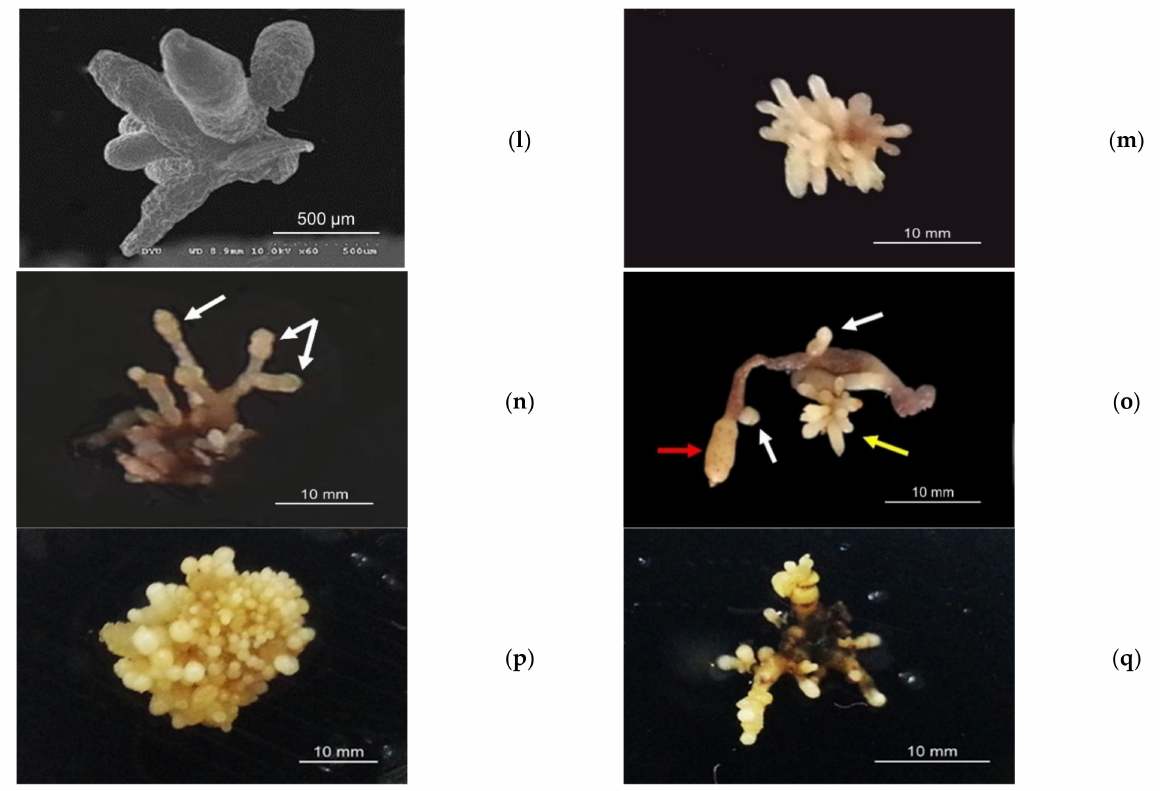
Figure 2. The in vitro asymbiotic germination of seeds of G. elata into protocorms and the develop- ment of juvenile rhizomes (jrhs). ( a ) The undifferentiated embryo in seeds started cell division and swelled. ( b ) Germinating seeds with seed coat attached, under SEM. ( c ) Protocorm on the left ( → ) started elongating. ( d ) The lower part of two protocorms began to elongate, forming a structure similar to globular embryo. ( e ) Cells were clearly seen in the head when the globular embryo-like structure grew more in advance, the lower part grew into a suspensor like structure. ( f ) The lower part of the two protocorms were elongated, and the left one grew more forward than the right one, which already showed a differentiated terminal bud. ( g ) A germinated seed multiplied to form more protocorms, under SEM. ( h ) One seed germinated into tween protocorms, the third protocorm was initiating (red → ). ( i ) A germinated seeds with seed coat still attached, proliferated and developed several protocorms. ( j ) Many protocorms formed from one germinated seed which had seed coat ( → ) still attached. ( k ) Protocorms generated several protocorms ( → ) on the Y2H medium; the photo on the right showed that the protocorms elongated into jrhs (red → ). ( l ) Multiple jrhs under SEM. ( m ) Jrhs proliferated on medium added with 2 g/L glutamic acid. ( n ) The tip of the apical bud of jrhs enlarged ( → ) on medium with 4 g/L MSG. ( o ) The formation of jrhs on CHT1 medium gradually showed gravitropism with the apical bud growing downward (red → ); the lateral buds were formed at the lower part of jrhs ( → ), and the secondary branching of the lateral buds was developed as well (yellow → ). ( p ) Protocorm proliferation on TM medium. ( q ) Jrhs induced more lateral buds on 2Glu medium, each rhizome bearing an apical bud and several lateral